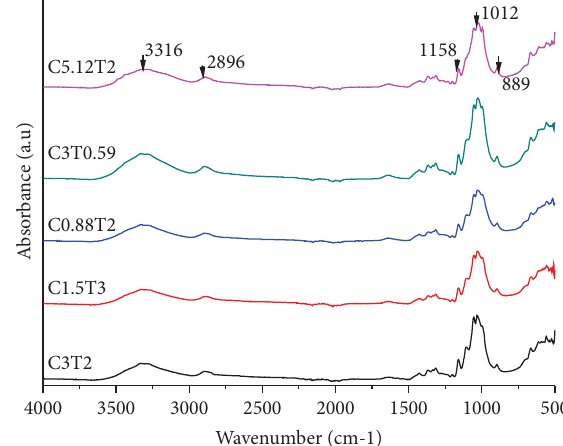
Figure 4: FTIR analysis on cellulose with various treatments of NaClO 2 concentration and bleaching time (C concentration of NaClO 2 (%); T � bleaching time